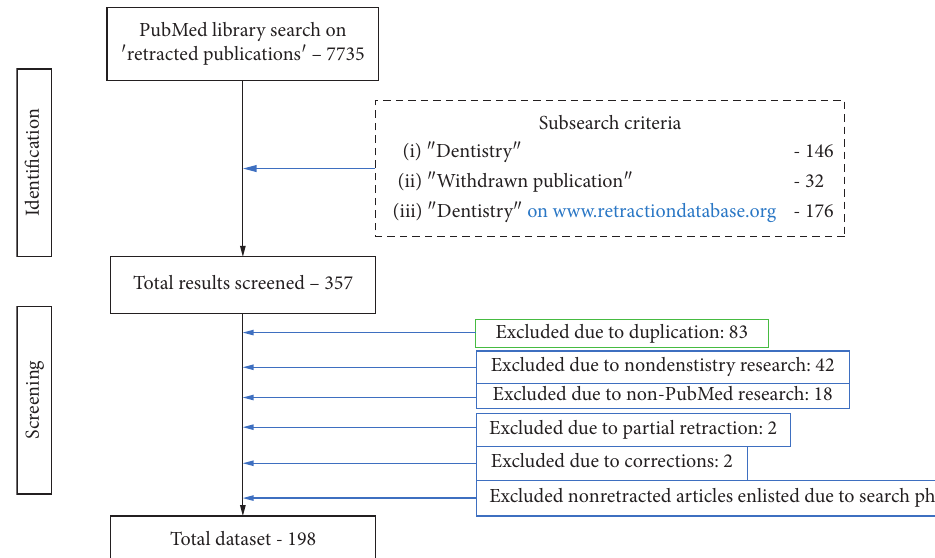
Figure 1: Flowchart depicting the steps in the methodology of identification and screening while assimilating the final database of articles. Final n � 198